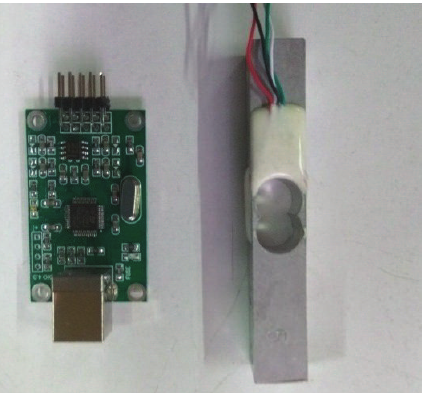
Figure 4: Force sensor and signal acquisition module.